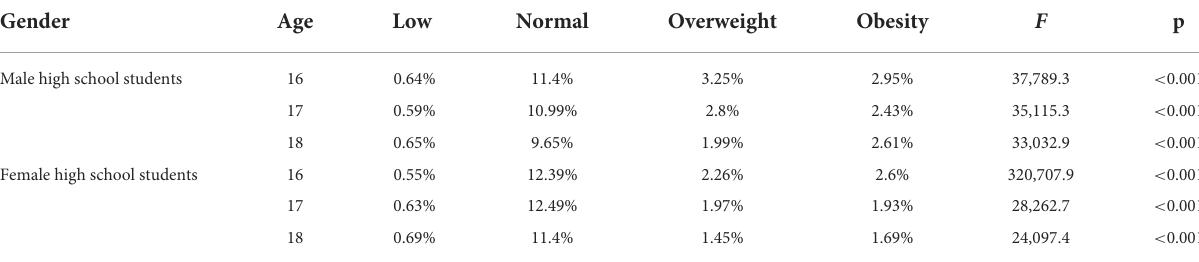
TABLE 1 The percentage of BMI level grouped by gender and age.